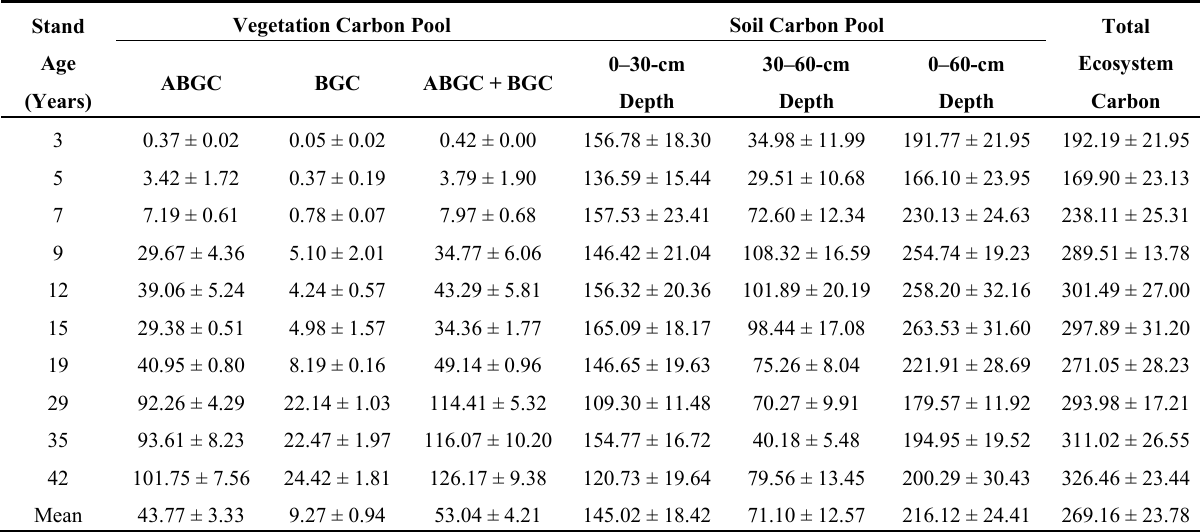
Values are means ± SD, n = 3; ABGC = aboveground biomass carbon in the tree layer; BGC = belowground biomass carbon in components of the tree